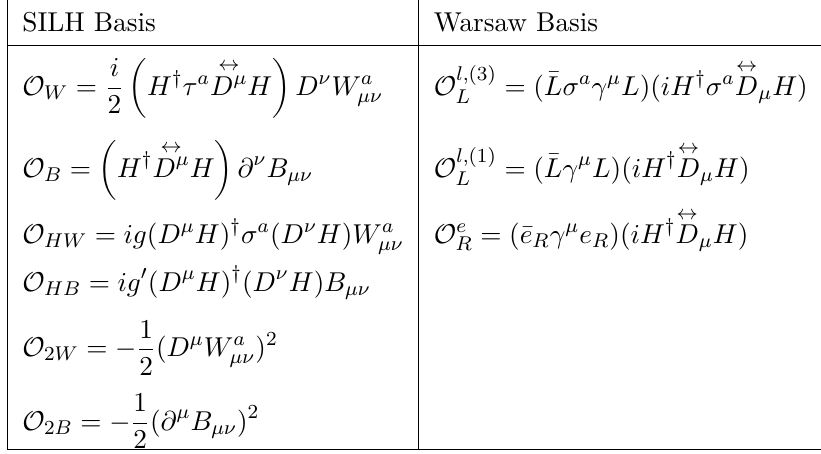
Table 2. Dimension-six operators contributing to e + e − → Zh, W + W − and ZBF Higgs production processes at high